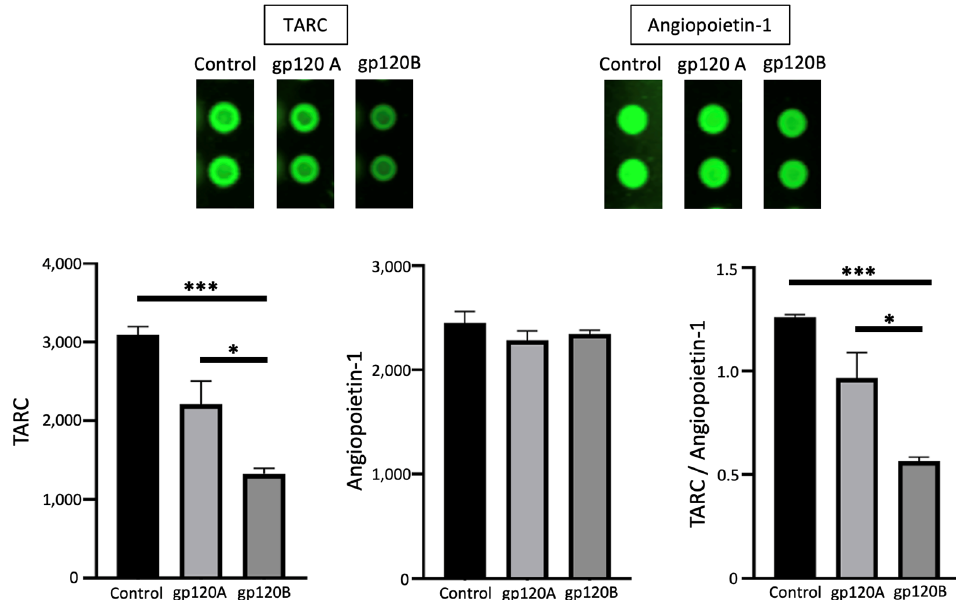
Figure 7. gp120 proteins of HIV-1 Group M Subtype A and Subtype B differentially affect TARC expression. Human pulmonary artery endothelial cells were treated with gp120 of HIV-1 Subtype A (gp120A) or Subtype B (gp120B) at 1 nM for 20 h. Expression patterns of various proteins were monitored using R&D Human XL Cytokine Array. TARC expression was found to be higher in gp120A-treated cells, while neighboring angiopoietin-1 spots were unchanged. Representative images are shown at the top. Densitometry values from two spots from each array were averaged, and statistical analysis was performed using results from three separate treatments/arrays. Bar graphs represent means ± SEM (N = 3 for gp120A and gp120B groups; N = 2 for untreated control). * p < 0.05. *** p < 0.001. The y-axis indicates the mean pixel density of protein spots.